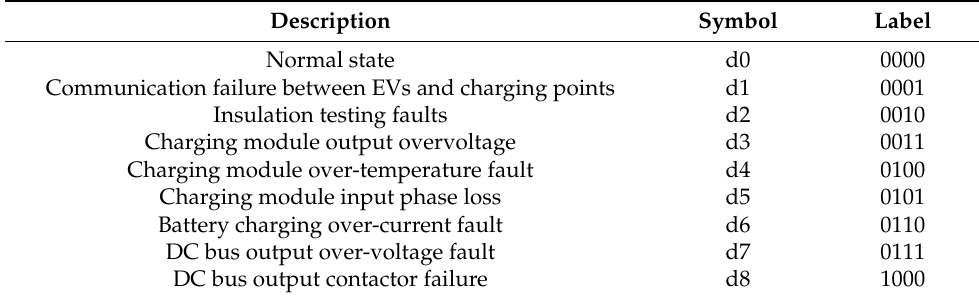
Table 1. The fault type of charging points and the fault